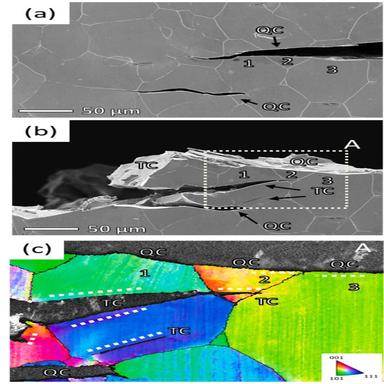
SEM images – (a, b) and EBSD IPF coloured-coded map – (c) demonstrating the specific region of the side surface of the Fe-2.5%Si alloy specimen after the first- – (a) and second-step loadings – (b, c). The region represented in (c) is the magnified area outlined by "A" - labelled frame in (b). The white dotted lines in (c) indicate the trace of crystallographic planes.